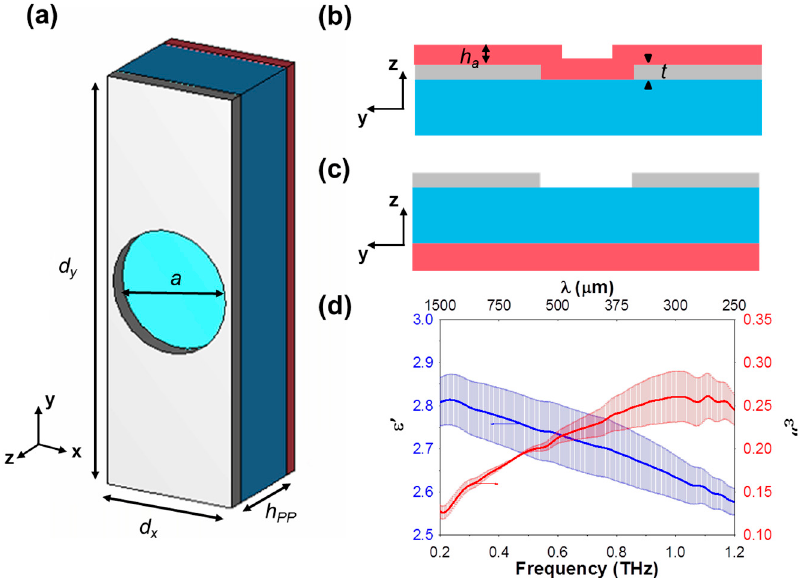
Figure 1. ( a ) Front view and ( b , c ) cross-section of the metasurface unit cell, showing the metallization (gray), PP substrate (blue) and analyte (red). Deposition of the analyte is done on the HA ( b ) and PP ( c ) faces. Dimensions: d x = 115.5 µ m, d y = 350 µ m , a = 105 µ m, h PP = 50; 75 µ m, t = 0.5 µ m, h a = 3; 7; 10; 13 µ m. ( d ) Measured frequency response of the complex analyte permittivity, with error bars: real (blue, left axis) and imaginary (red, right axis) components.